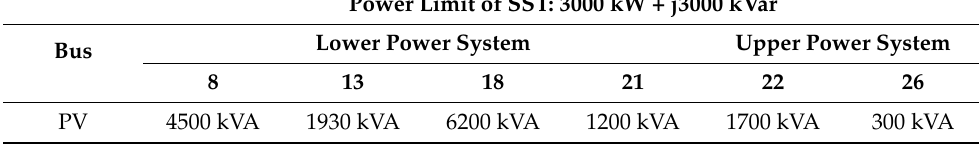
Table 2. Load type and